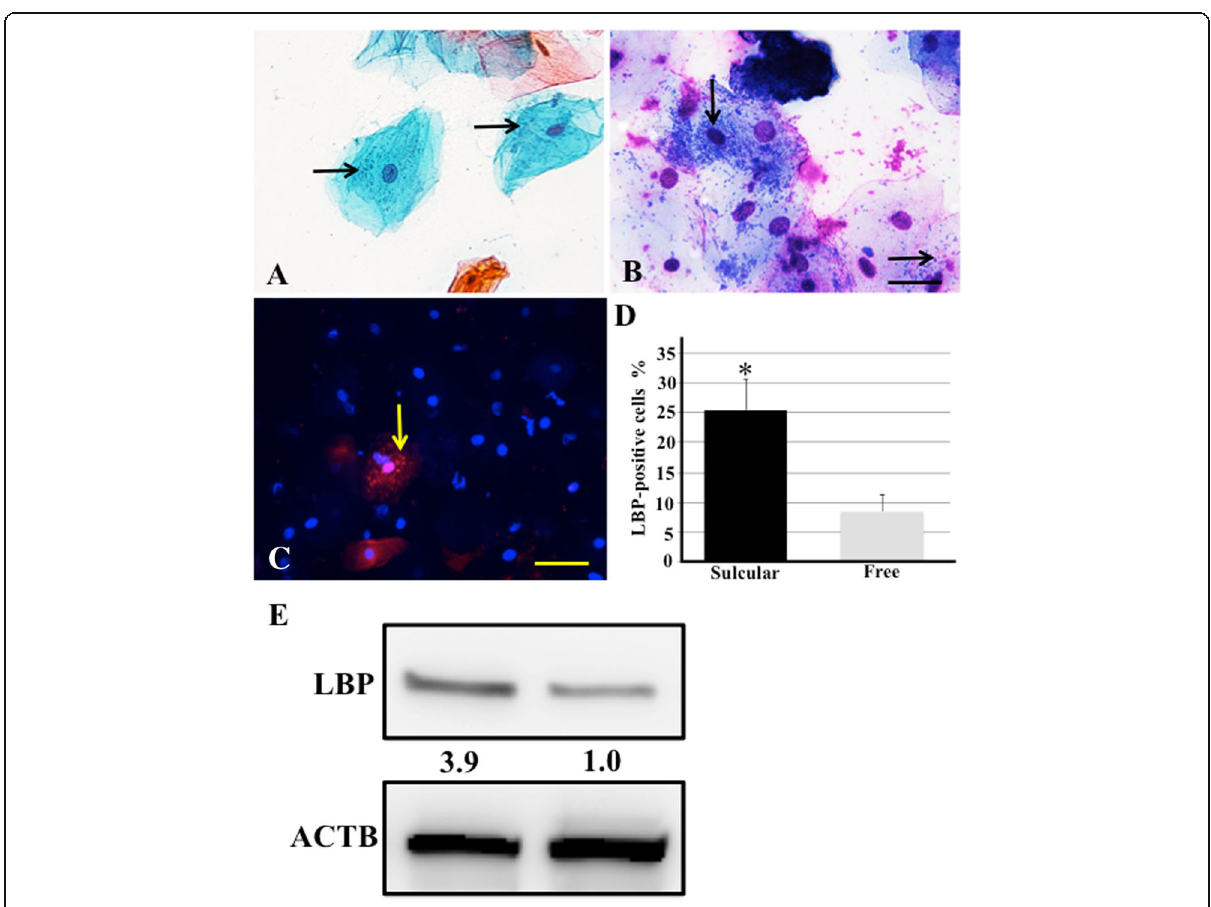
Fig. 2 Intracellular detection of bacterial pathogens in exfoliative sulcular keratinocytes. a and b Representative images of exfoliative epithelial keratinocytes stained with Pap ( a ) and May-Giemsa ( b ) staining. Arrows, intracytoplasmic bacterial particles. Bar = 50 μ m. c Immunocytochemical evaluation of LBP expression in the exfoliative sulcular keratinocytes. LBP antibody staining showed red-colored positive particles in the cytoplasm of sulcular cells. The nucleus was stained with Hoechst 33342 (blue). Arrows, intracytoplasmic bacterial particles. Bar = 50 μ m. d Quantitative analysis of percentage of LBP-positive cells in exfoliative sulcular keratinocytes. The mean number of percentage of LBP-positive cells ± SD from five independent studies. *Significantly different at P < 0.05 compared with exfoliative cells from the free gingiva. e Western blotting analysis of LBP expression in exfoliative keratinocytes from gingival sulcus and free gingiva. β -actin (ACTB) was used as a loading control. Band densities were presented as LBP expression fold-increases (normalized to ACTB) and compared with the results for exfoliative cells from free gingiva. Quantification results are shown below the corresponding blots. All experiments were performed in